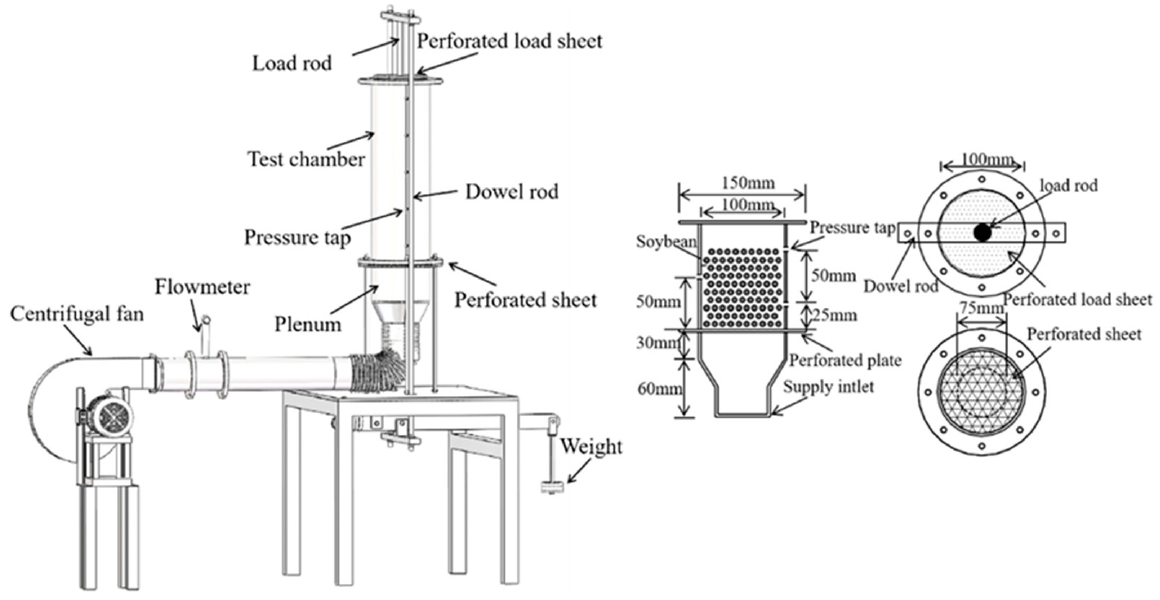
Figure 1. Schematic diagram of measuring soybean airflow resistance under vertical pressure.